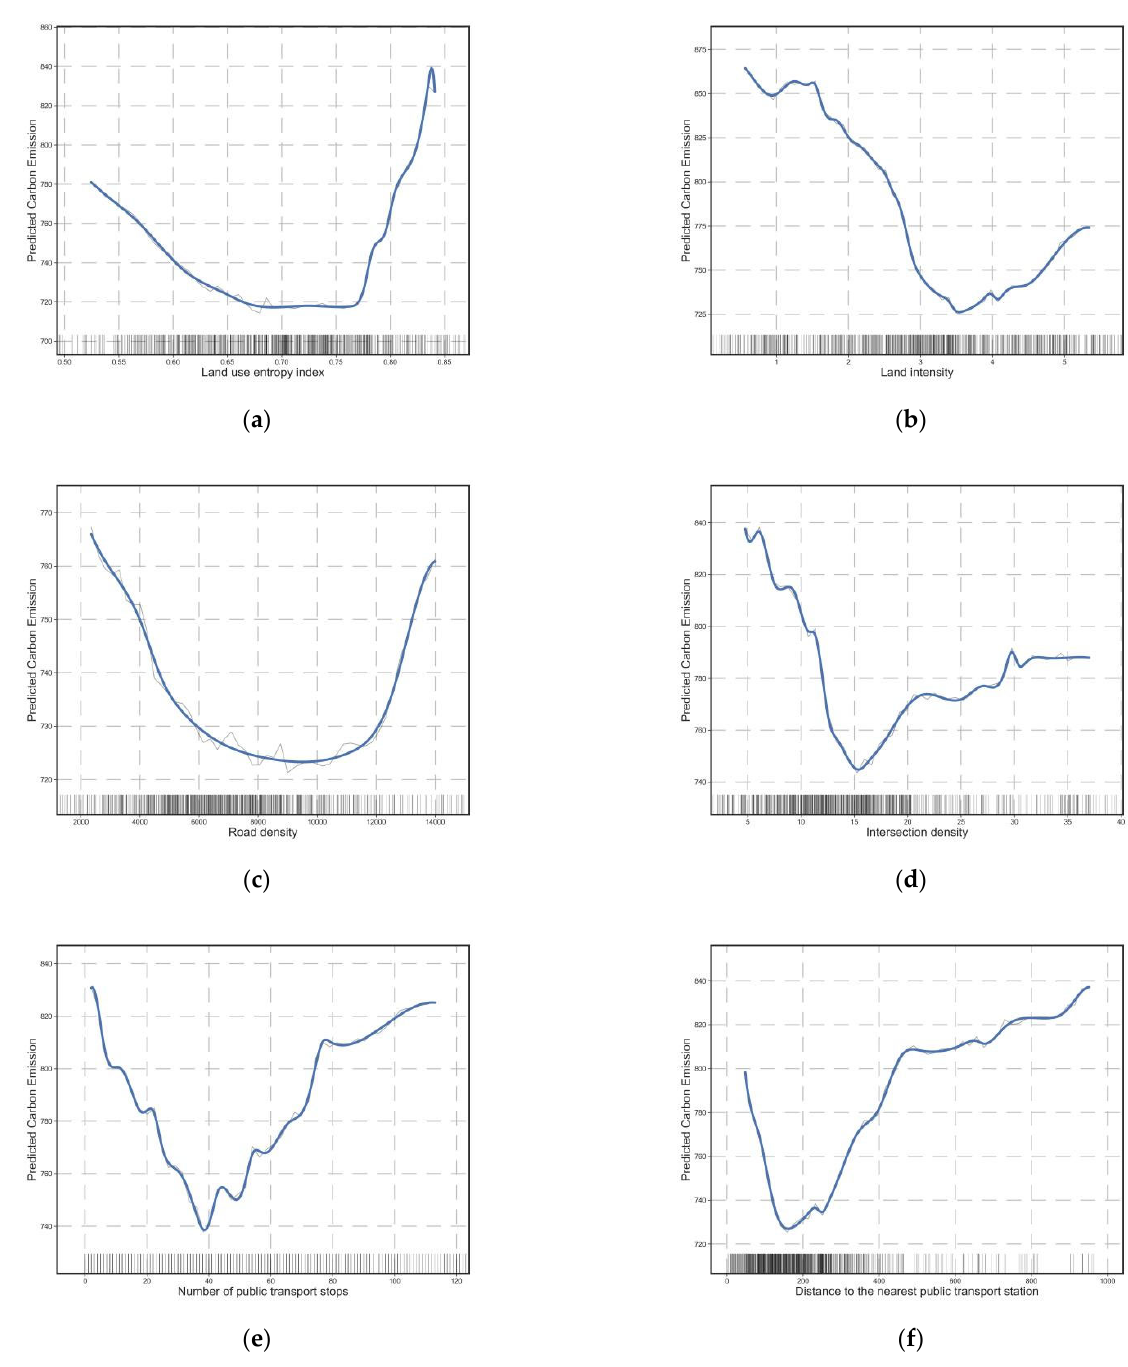
Figure 5. Influence of other built environment factors on commuting CO 2 . ( a ) The relationship between land use entropy index and commuting CO 2 ; ( b ) The relationship between land development intensity and commuting CO 2 ; ( c ) The relationship between road intensity and commuting CO 2 ; ( d ) The relationship between intersection density and commuting CO 2 ; ( e ) The relationship between the number of public transport stops and commuting CO 2 ; ( f ) The relationship between the distance to the nearest public transport station and commuting CO 2.